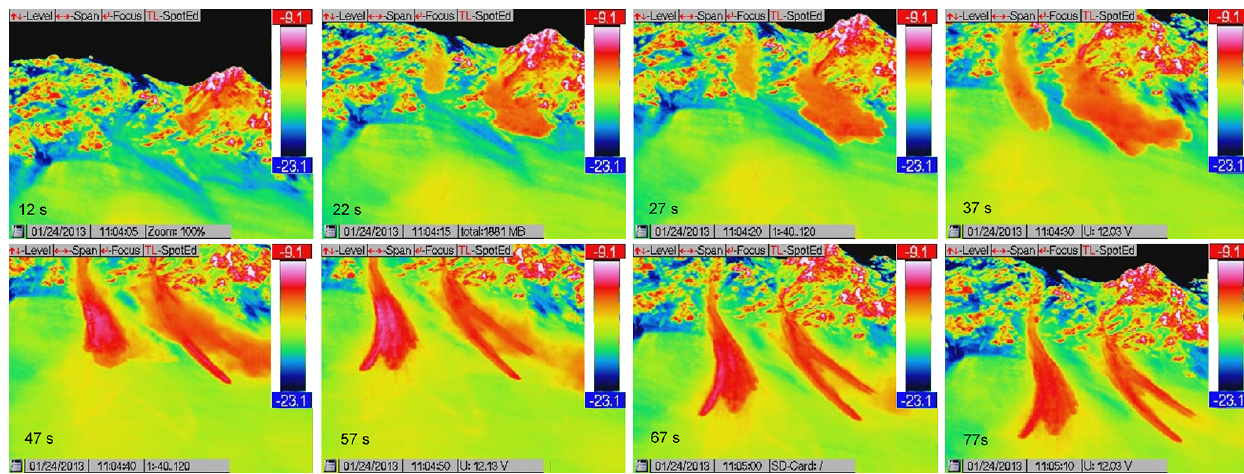
Figure 3. Screenshot of IRT camera videos for avalanche #1a and #1b. The first picture was taken 12s after the avalanche released.